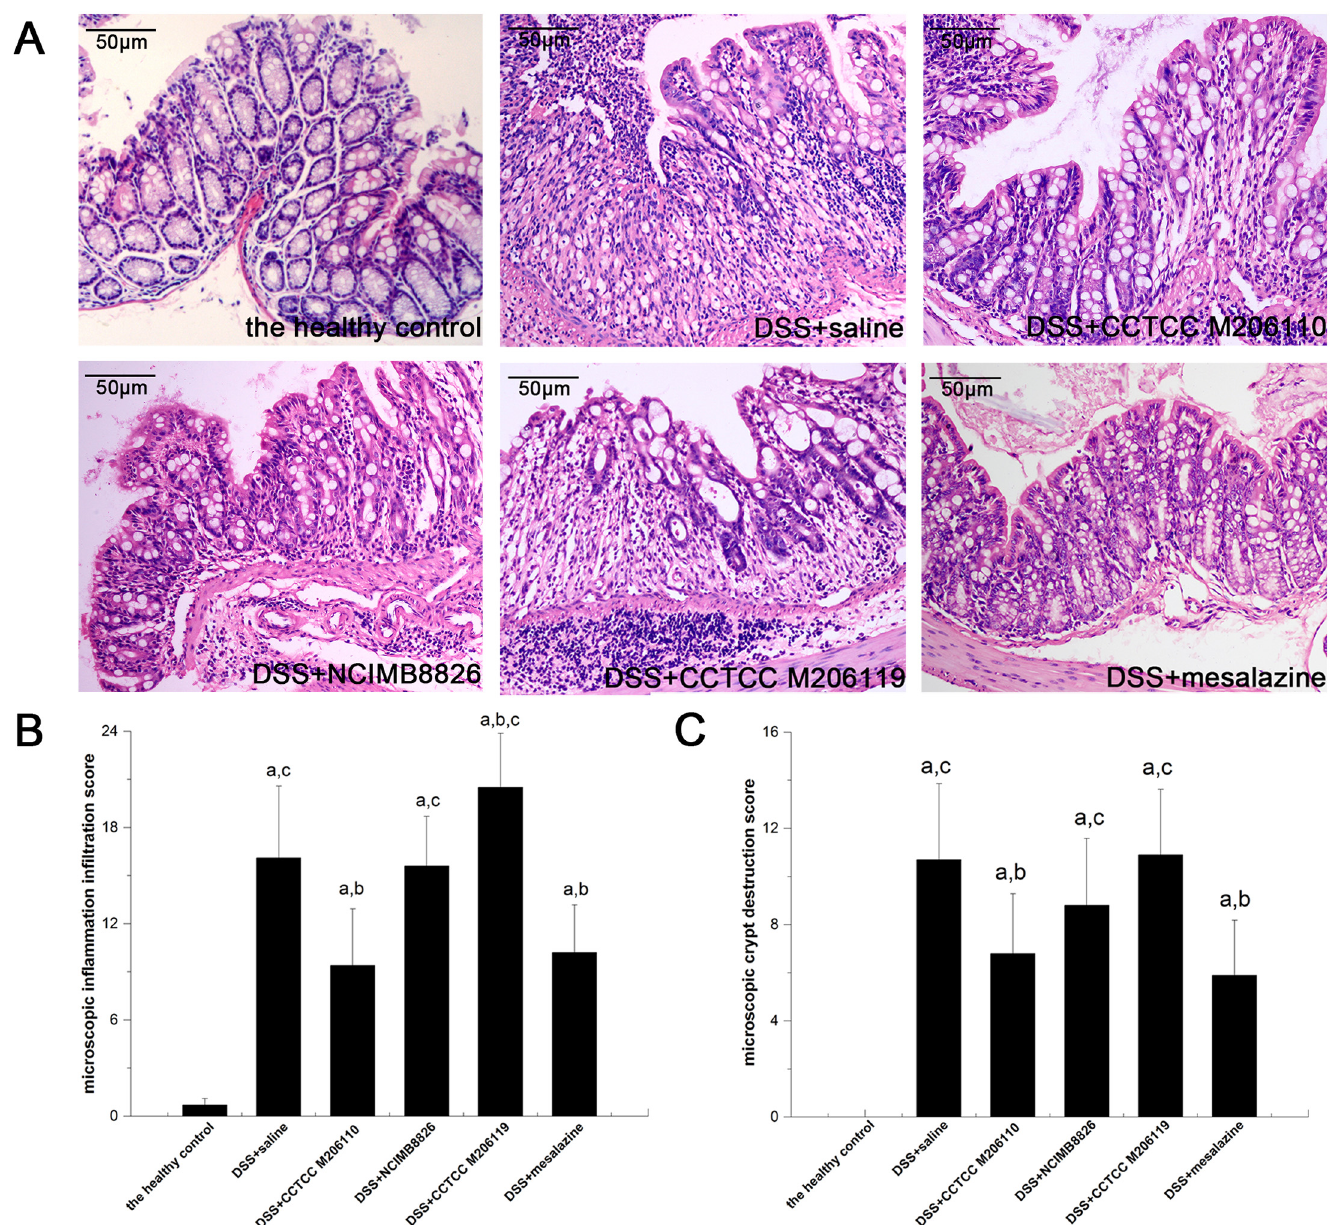
Fig 3. Effects of Lactobacillus strain treatments on colitis-induced changes in intestinal histopathologic features. (A) Histologic analysis of representative colons from the mice (original magnification, hematoxylin and eosin staining, 200×). (B) Microscopic inflammatory infiltration score; (C) Microscopic crypt destruction score. a P < 0.05 vs. the healthy control group; b P < 0.05 vs. the negative (saline) control group; c P < 0.05 vs. the positive (mesalazine) control